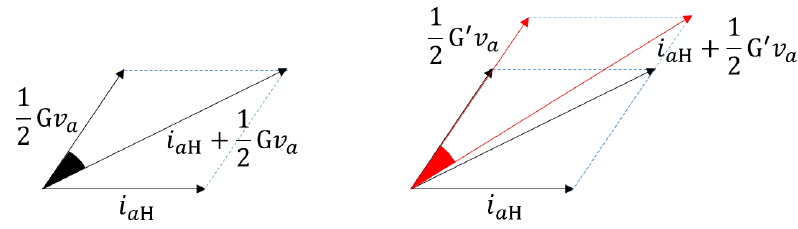
Figure 2. Vector plots of the degrees of two ITSFs under the same operating